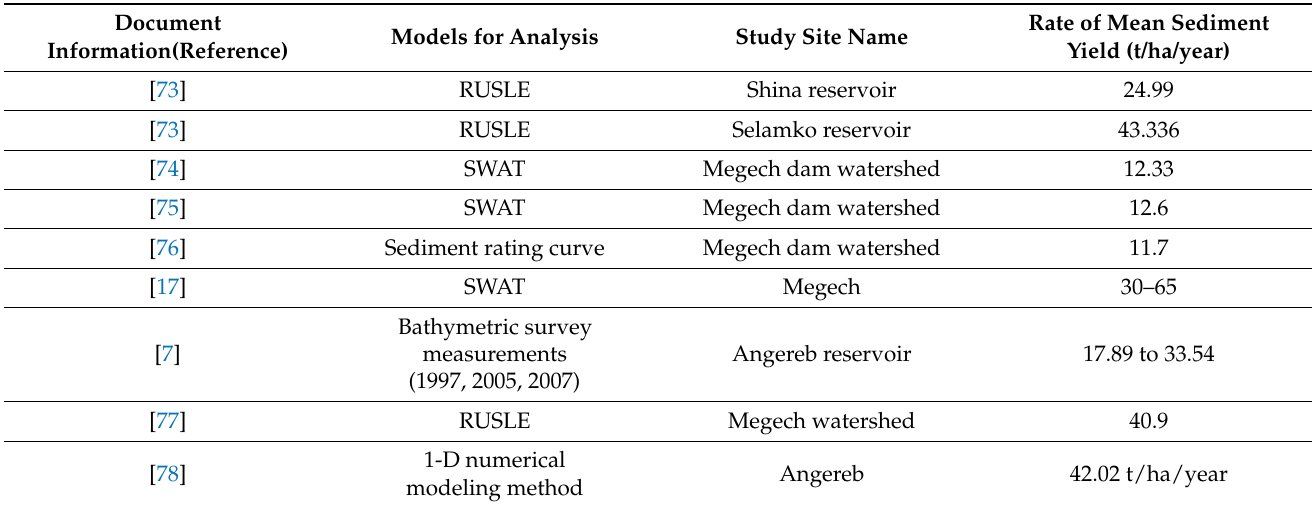
Table 4. Summary of previous studies in and nearby of the study